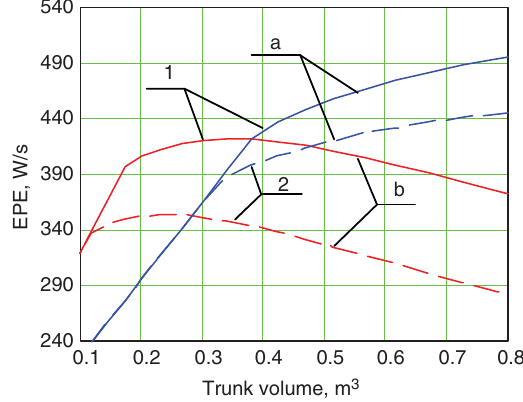
Fig. 1. The effectiveness of various styles of limbing in different operational conditions: a – with the work mix; b – without the work mix; 1 – power of harvester head